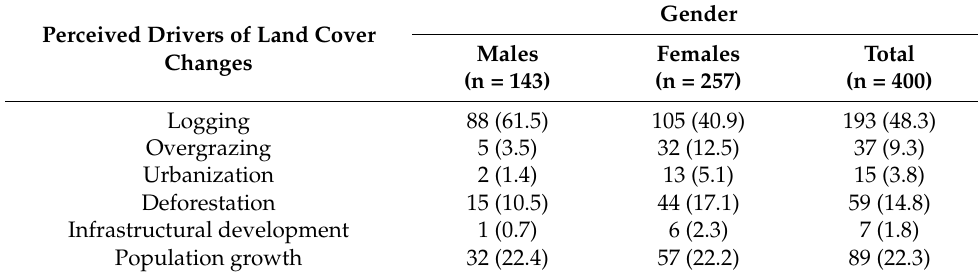
Table 10. Perceived drivers of land cover changes in the Bobiri forest reserve,